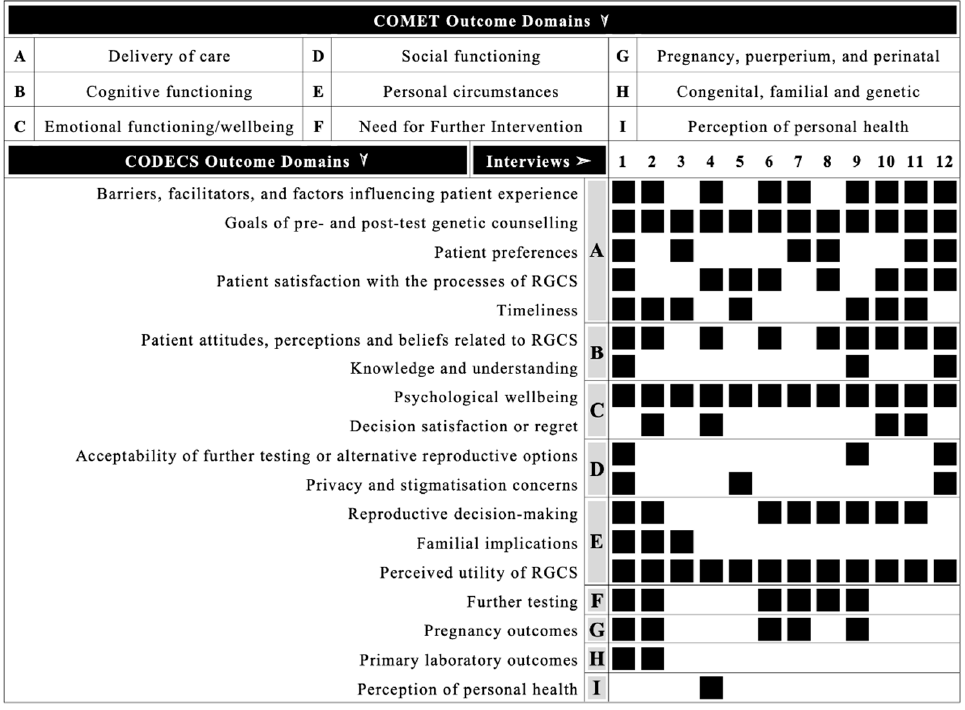
Figure 2. Block diagram illustrating the CODECS outcome domains represented across interviews, with higher level COMET taxonomy outcome domains indicated by A–I.